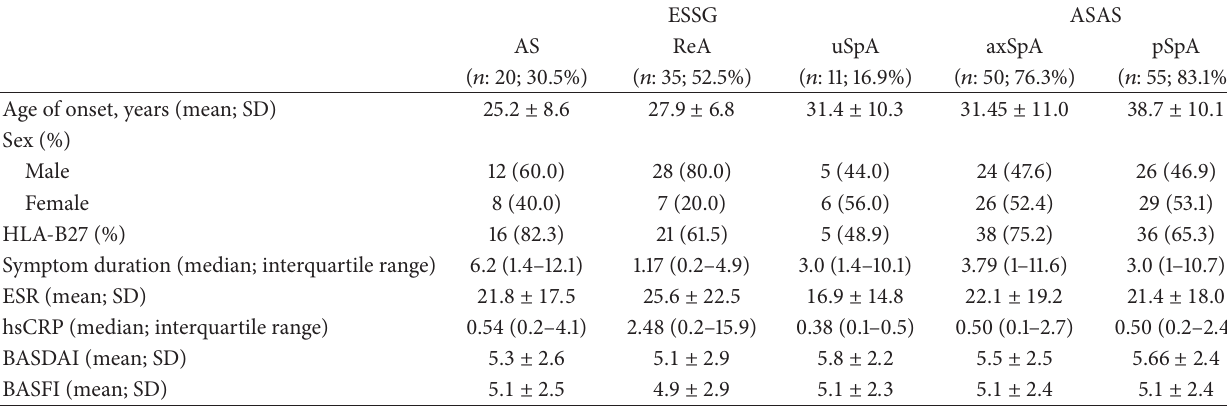
Table 1: Characteristics of the study population.